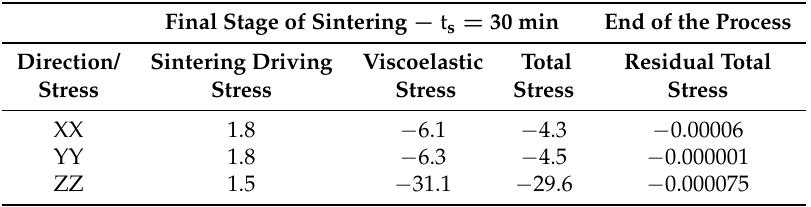
Table 2. Summary of macroscopic stresses in three main directions at the final stage of sintering and the end of powder metallurgy process